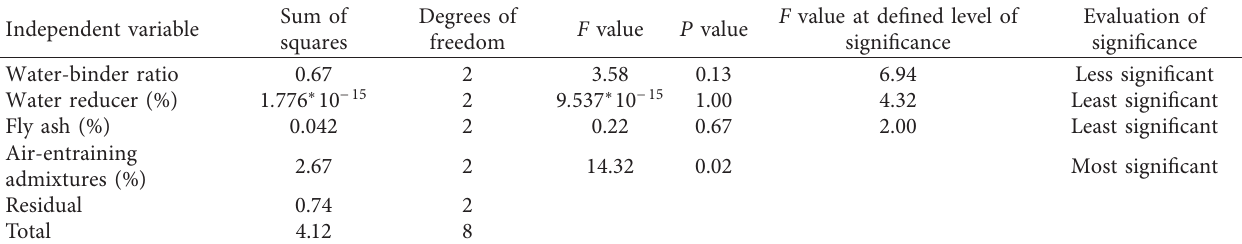
Table 9: ANOVA for gas